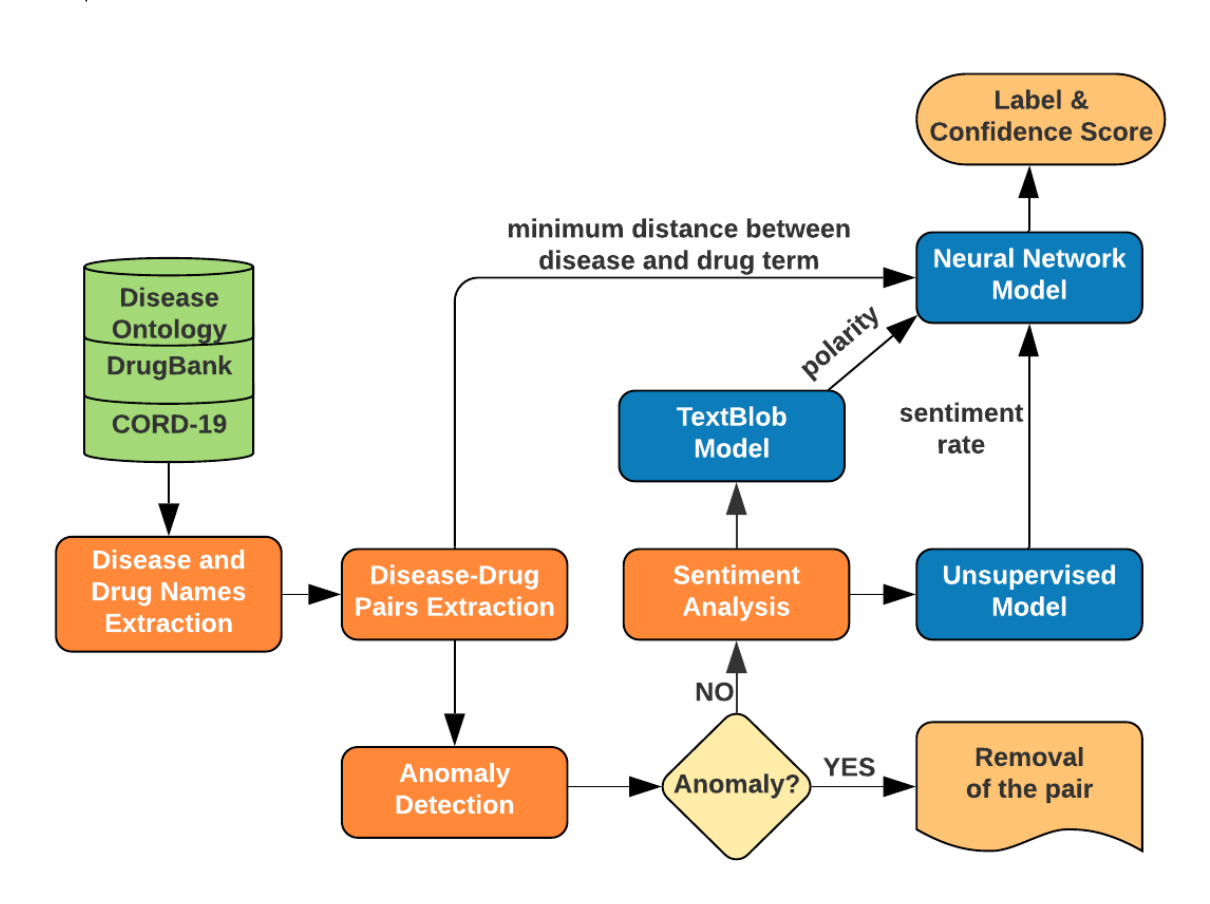
Figure 1. Flowchart of extracting disease-drug interactions and predicting the effectiveness of drugs against diseases with confidence scores. CORD-19: COVID-19 Open Research